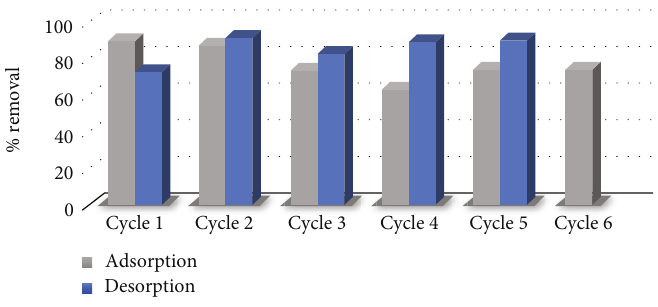
Figure 12: Regeneration of ACO